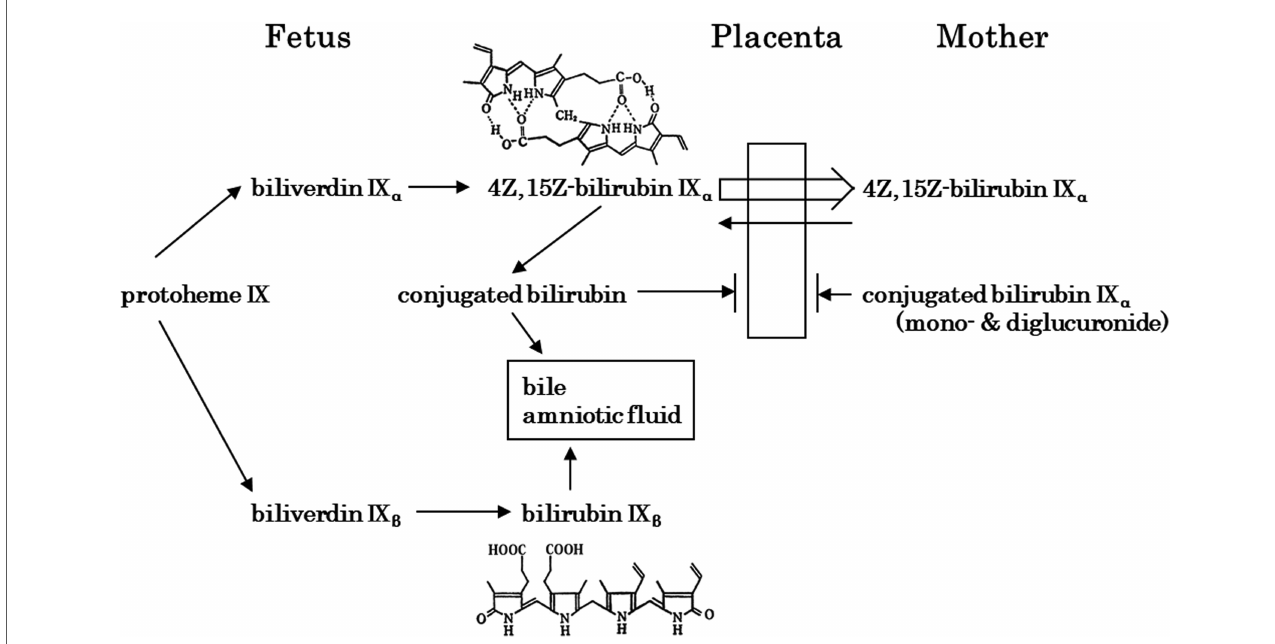
FIGURE 3 Fetal bilirubin metabolism [modi fi ed in part from itoh (65)]. Bilirubin IX β , which is produced in early fetal life, is hydrophilic and is excreted via the gastrointestinal tract and amniotic fl uid. In contrast, 4Z,15Z -bilirubin IX α , which is produced later in life, is hydrophobic and crosses the placenta for excretion by the mother. At the fetal stage, the extremely low activity of 4Z,15Z -bilirubin IX α -conjugating enzymes is important.